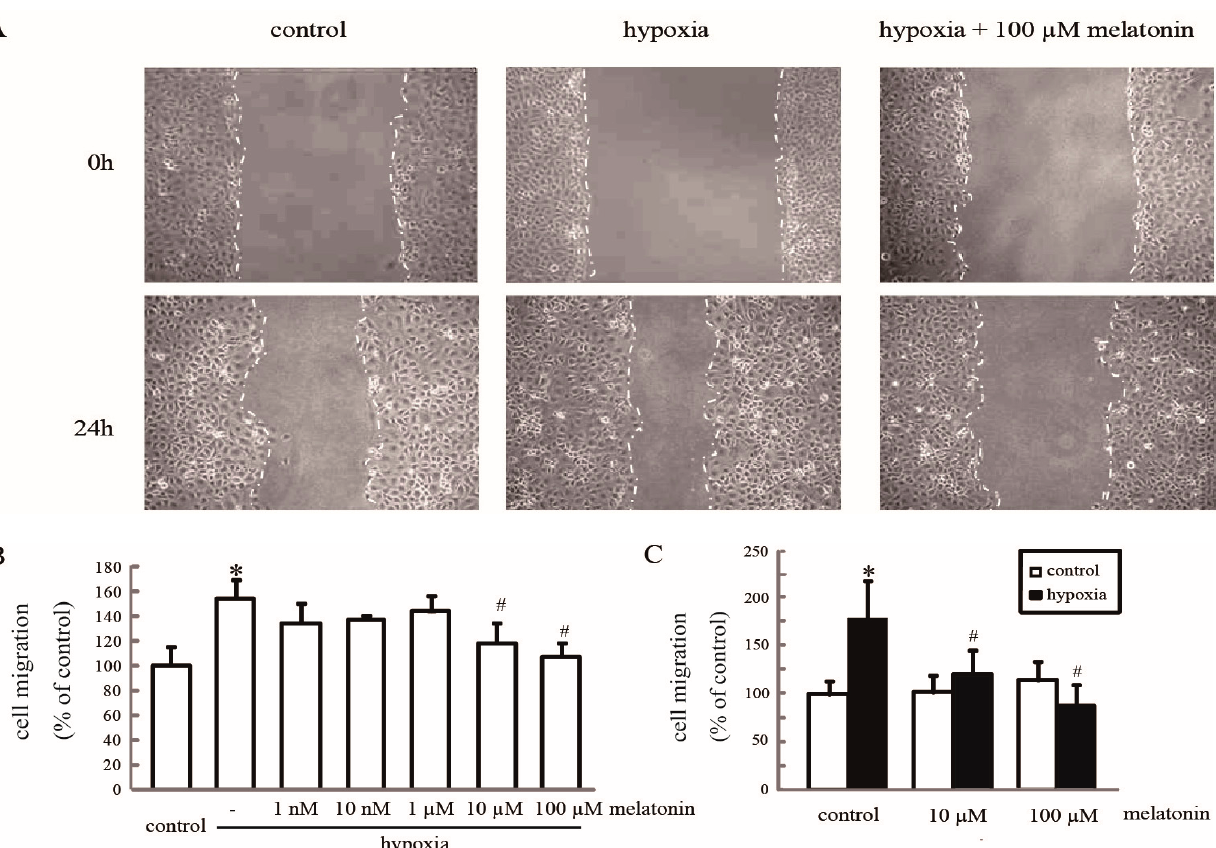
Figure 1. The effect of melatonin on hypoxia-induced HUVEC migration. ( A ) HUVECs were incubated with or without melatonin at the indicated concentrations and then exposed to hypoxia for 24 h. A representative wound healing assay is presented. The gap is indicated by white dotted lines; ( B , C ) The relative cell migration rate was determined using the wound closure assay. The values are presented as the mean ± SD of three independent experiments; and ( D ) Cell migration was assessed by the Transwell migration assay in HUVECs incubated with 0.1 and 1 mM melatonin and then exposed to hypoxia for 3 h. * p < 0.05, referring to the difference between cells treated with and without hypoxia; # p < 0.05, referring to the difference between cells treated with melatonin and hypoxia relative to the cells exposed to hypoxia